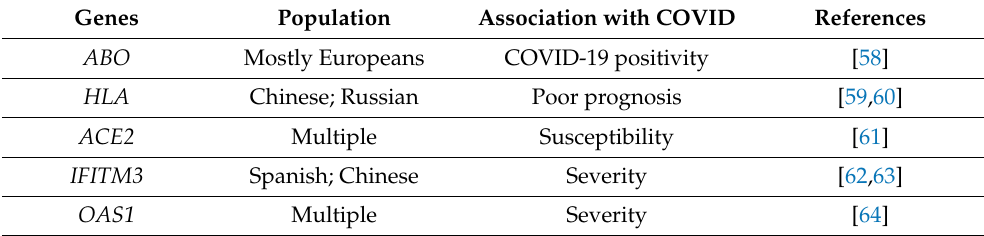
Table 3. Genetic factors associated with COVID-19